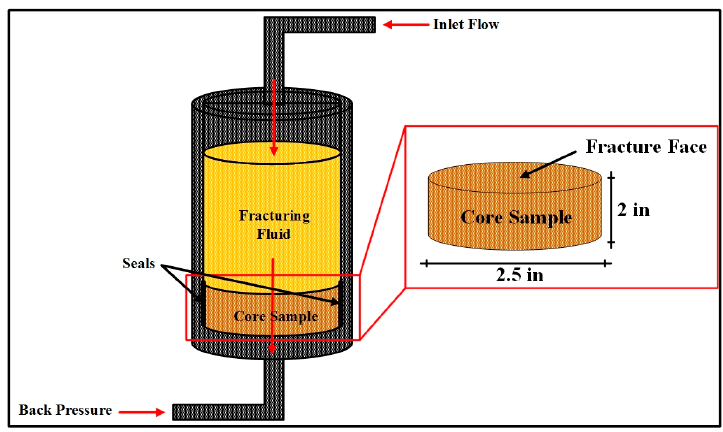
Figure 2. Cell and Core specifications of the continuous pumping set up.